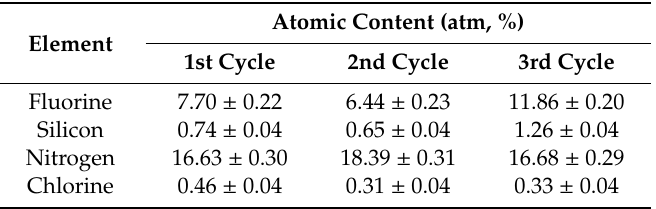
Table 3. The atomic contents of fluorine, silicon, nitrogen, and chlorine on the modified cotton fabric in each washing cycle.